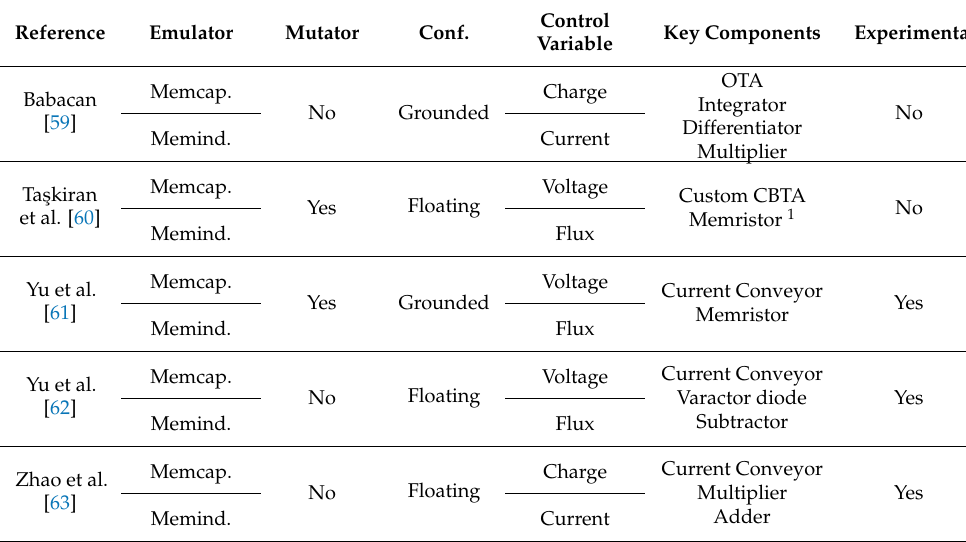
Table 3. Comparison among of the different universal emulators cited in this